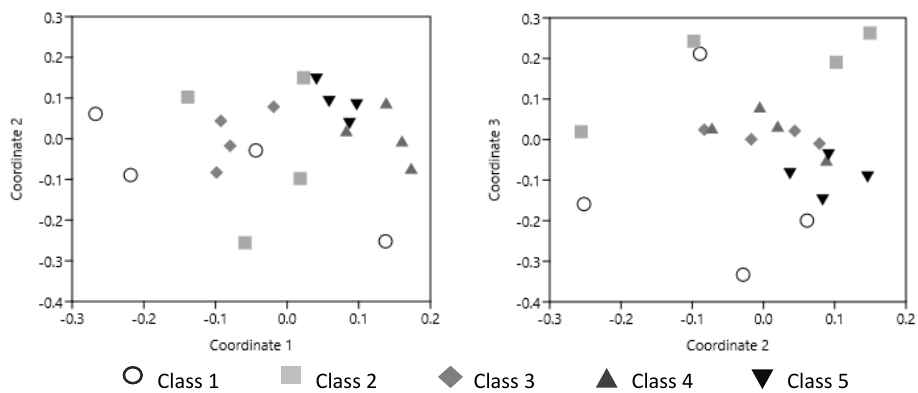
Figure 7. nMDS ordination plots of ciliate 18S rDNA gene obtained by PCR-DGGE from black pine deadwood at different decay classes [98].